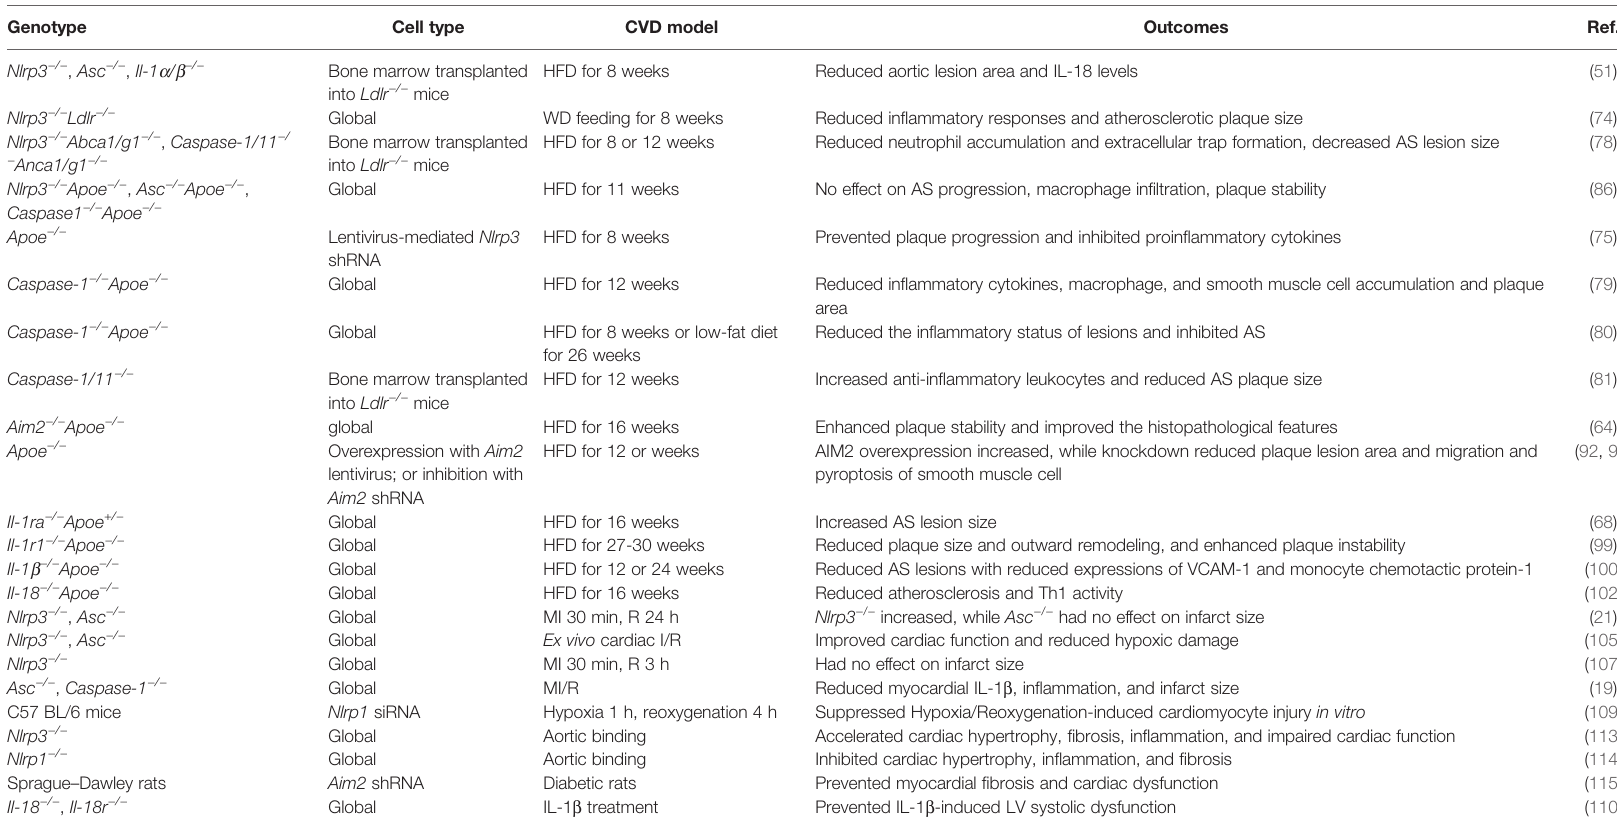
TABLE 1 | Experimental evidence on the role of in fl ammasomes in animal models of CVDs.